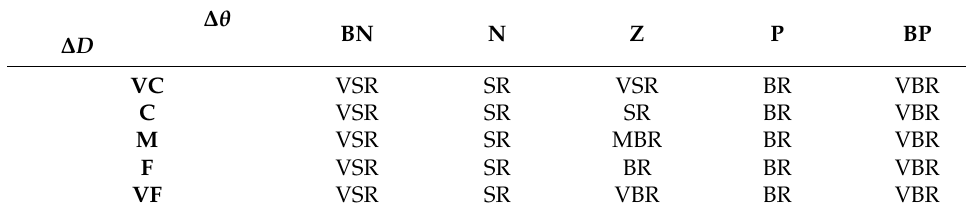
Figure 7. ( a ) The membership functions of the distance error; ( b ) The membership functions of the angle error; ( c ) The membership functions of the right wheel angular velocity; ( d ) The membership functions of the left wheel angular velocity. Table 1. Parameters used for inputs of the initial fuzzy logic controller. Table 3. The rules of the right wheel angular velocity.